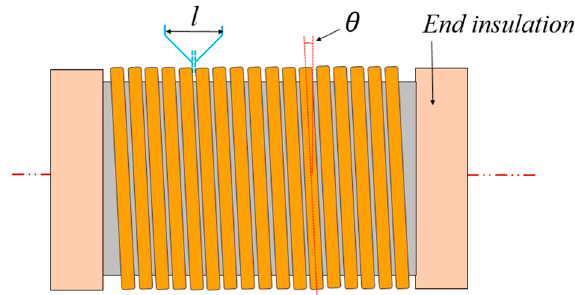
Figure 4. Instruction of winding angle and wire spacing.